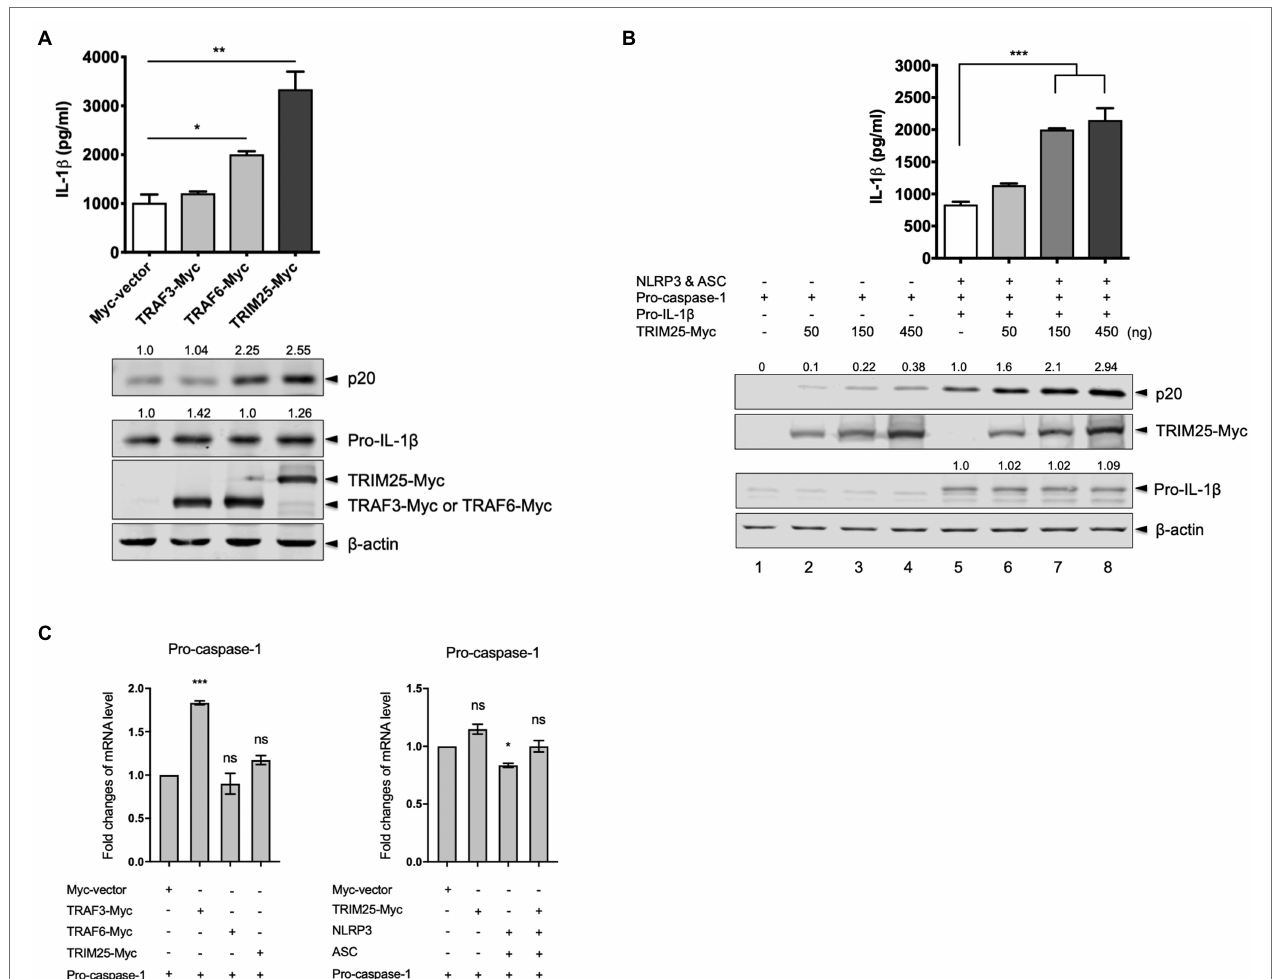
FIGURE 1 | Tripartite motif-containing protein 25 (TRIM25) enhances the nucleotide-binding domain and leucine-rich repeat-containing protein 3 (NLRP3) inflammasome activity. (A) Human embryonic kidney 293T (HEK293T) cells were transfected with plasmids expressing porcine NLRP3, apoptosis-associated speck- like protein containing caspase recruitment domain (ASC), pro-caspase-1, and pro-interleukin-1 beta (IL-1 β ) along with an empty Myc-vector or a plasmid expressing Myc-tagged porcine TRAF3, TRAF6, or TRIM25 for 16 h. Porcine IL-1 β levels from cell-free supernatants were measured by ELISA. From cell lysates, the expression of proteins (p20 subunit of active caspase-1, pro-IL-1 β , Myc-tagged TRAF3, TRAF6, and TRIM25) was analyzed by Western blotting, while the endogenous β -actin level was monitored as a loading control. Relative intensities of p20 and pro-IL-1 β to that in the sample with Myc-vector were shown above each band. (B) HEK293T cells were transfected with a plasmid expressing porcine pro-caspase-1 (lanes 1–4) or plasmids expressing porcine NLRP3 inflammasome components plus pro-IL-1 β (lanes 5–8) along with increasing amounts of Myc-tagged porcine TRIM25. An empty Myc-vector was included where needed to keep the total DNA amount constant. Porcine IL-1 β secretion and protein expression as indicated at 16 h were analyzed as in (A) . Relative intensities of p20 (lanes 1–8) and pro-IL-1 β (lanes 5–8) to that in lane 5 were shown as in (A) . (C) HEK293T cells were transfected with plasmids as indicated for 18 h. Pro-caspase-1 mRNA levels were measured by quantitative PCR and expressed as fold changes over the expression level in cells transfected with pro-caspase-1 construct and an empty Myc-vector. Statistical analysis was performed with one-way ANOVA. ns, not significant; * p < 0.05; ** p < 0.01; and *** p < 0.001. Results are representative of three independent